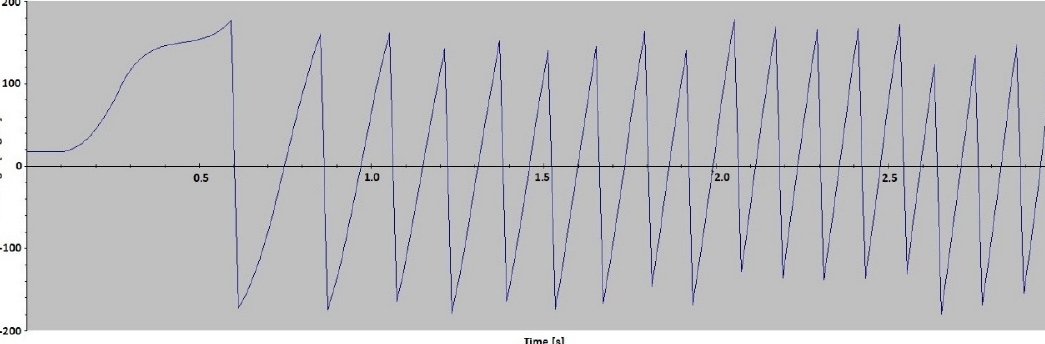
Figure 25. Simulation results of the load angle of Generator 2 during the three-phase fault with the fault duration of 172 ms.